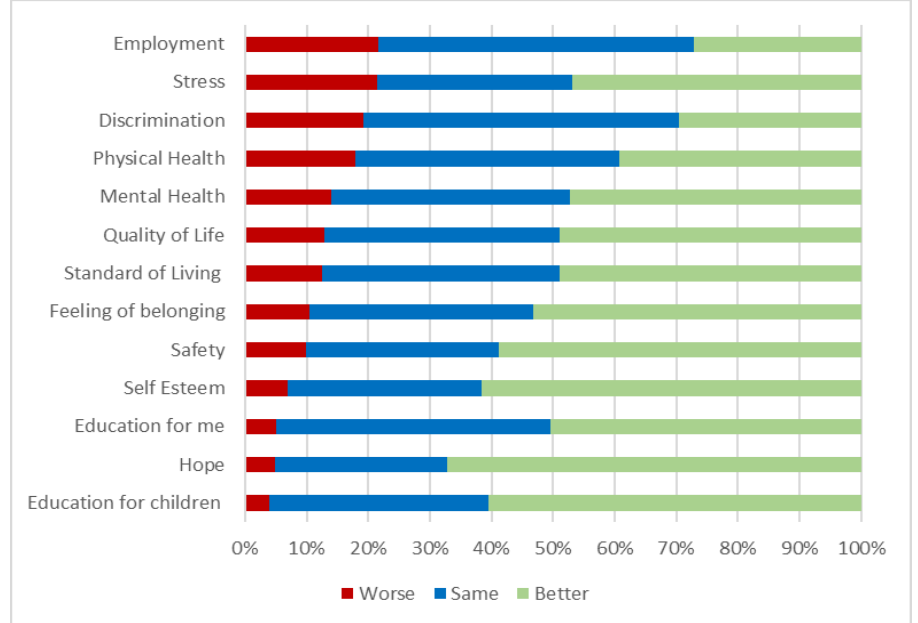
Figure 1. Tenant reported changes since moving into affordable housing.